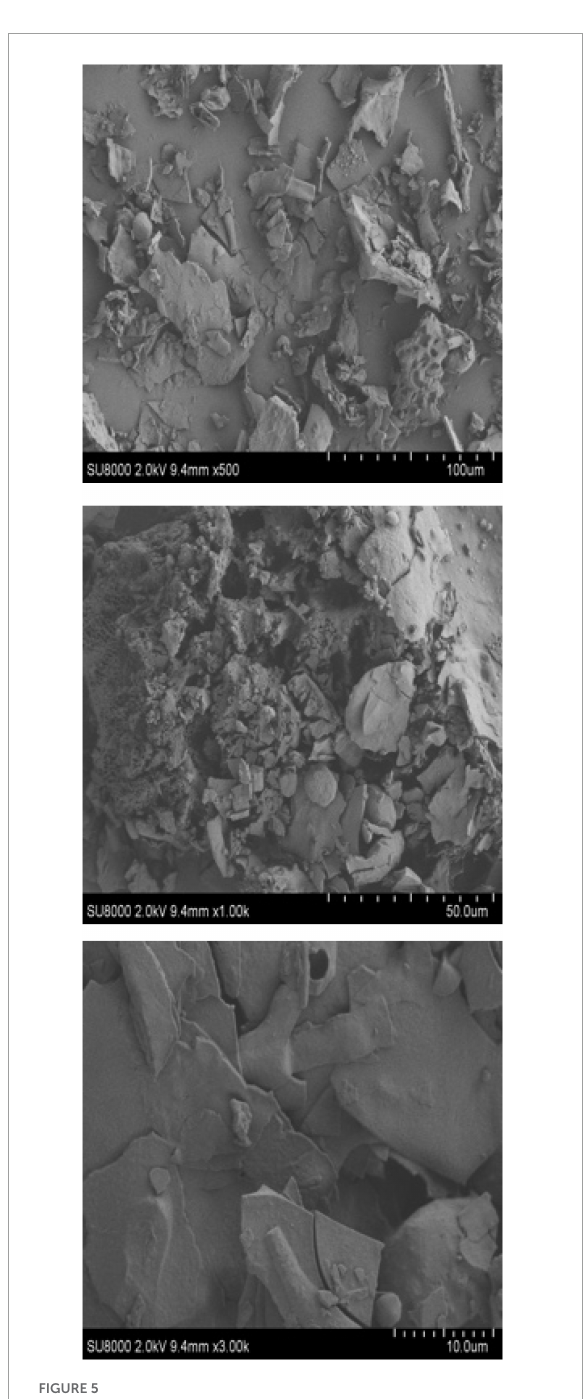
FIGURE5 SEM photo of the surface structure of EFP-2.